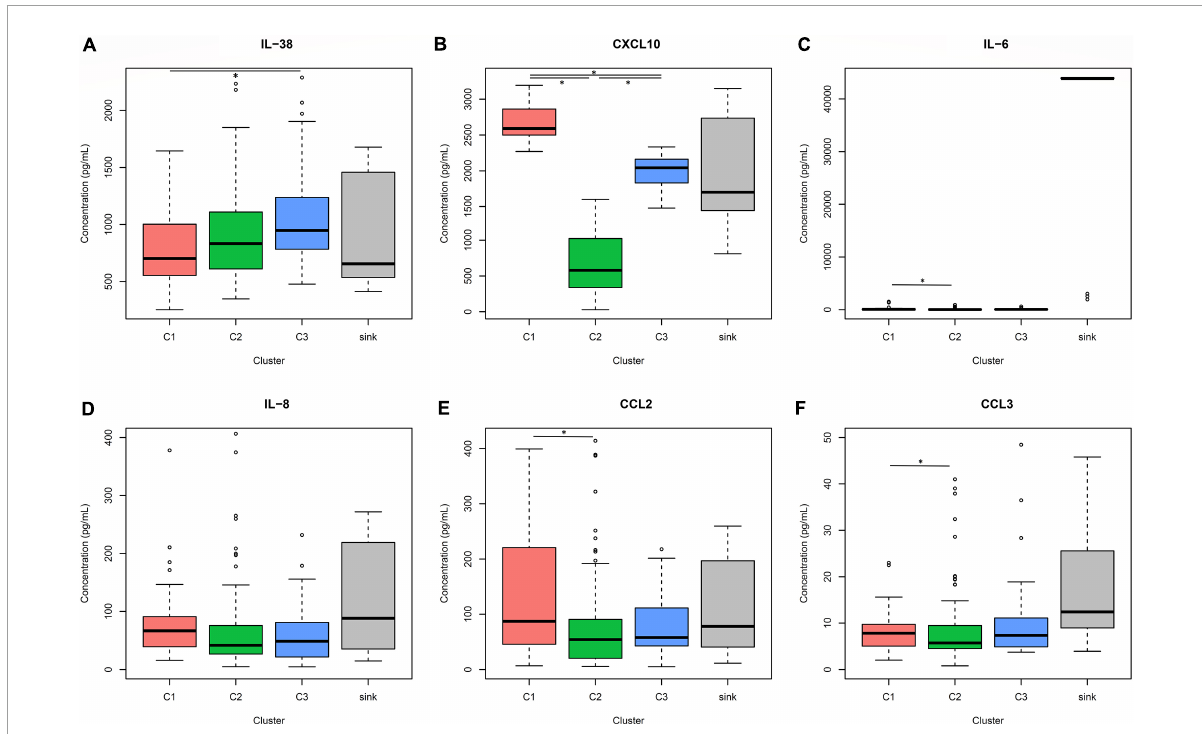
FIGURE4 Cytokine concentrations among clusters. Analysis of the concentration values of IL-38 (A) , CXCL10 (B) , IL-6 (C) , IL-8 (D) , CCL2 (E) , and MIP-1 alpha (F) among the clusters was performed. Statistical analysis using ANOVA and Tukey test was performed excluding the sink group. *Significant differences were found in IL-38 concentration C1 vs. C3 p < 0.01; CXCL10 concentration C1 vs. C2 vs. C3 p < 0.001; IL-6, CCL2, CCL3 concentrations C1 vs. C2 p <